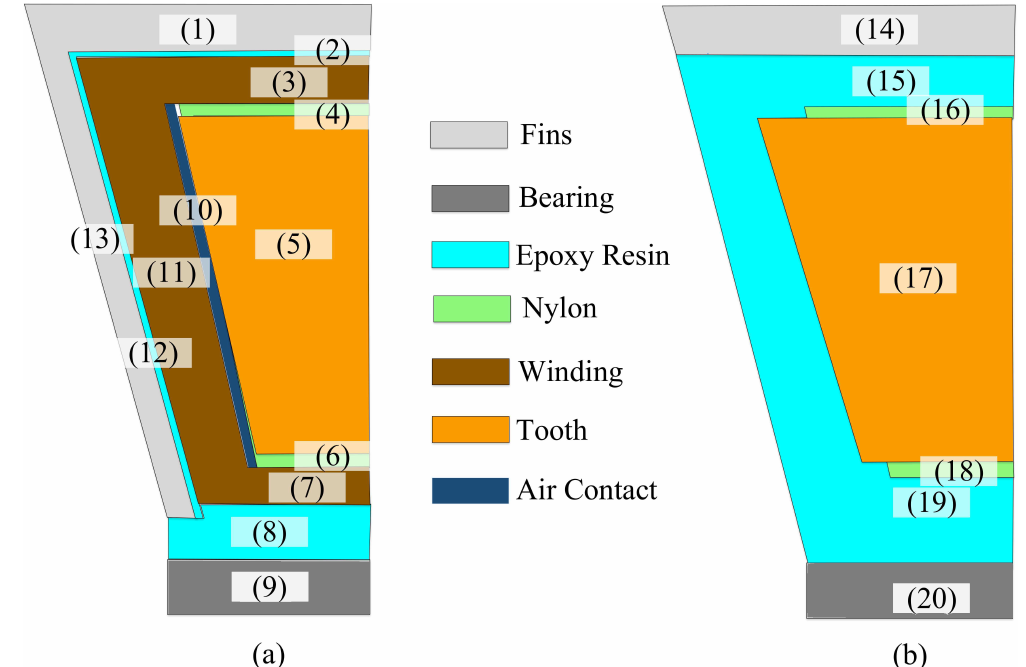
Figure 6. Regions of stator modeled part. ( a ) Section I at the center of the tooth; ( b ) Section II at the center of the tooth tips.